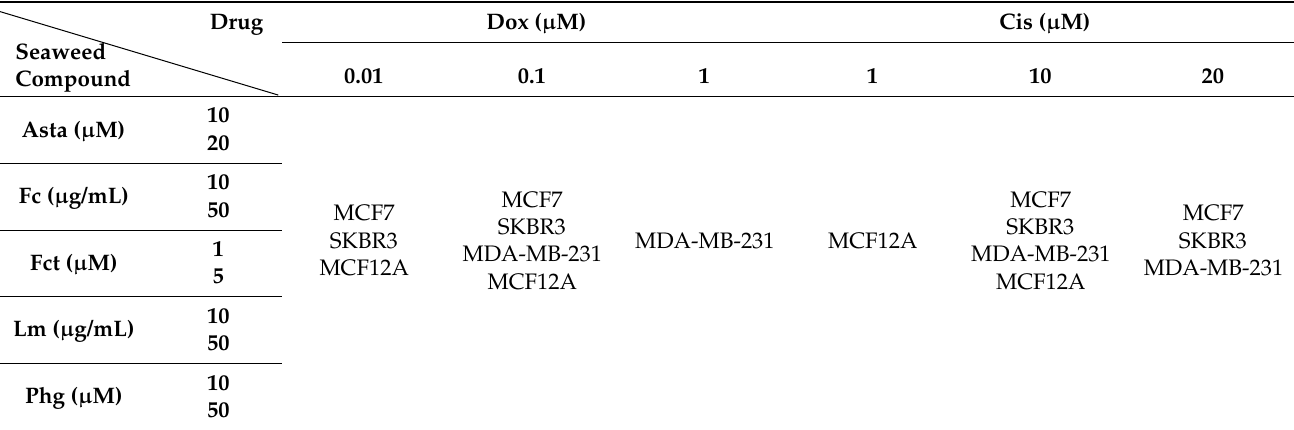
Table 1. Tested concentrations of bioactive seaweed compounds and reference drugs Table 2. Concentrations of bioactive seaweed compounds and reference drugs used for combinations Chemicals Tested Concentrations Astaxanthin Seaweed Compound